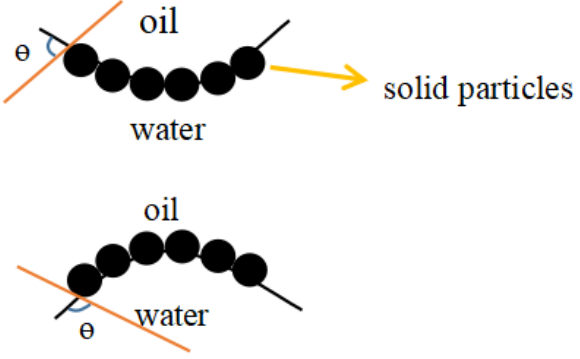
Figure 1. Description of two types of Pickering emulsions.